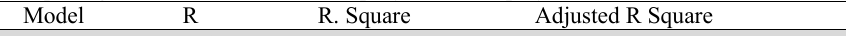
Multiple regressions between leadership styles and employee innovative work behavior